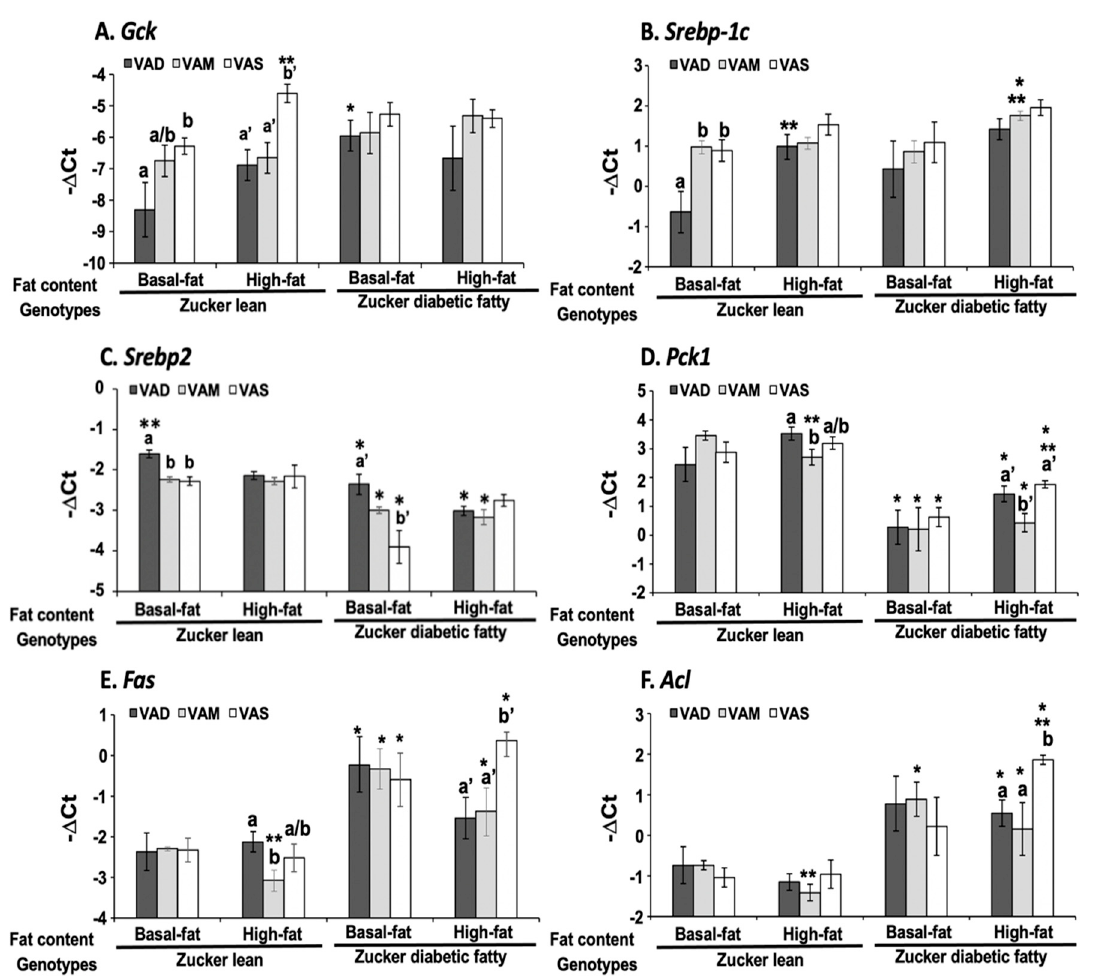
Figure 8. The mRNA levels of Gck (A) , Srebp ‐ 1c (B) , Srebp2 (C) , Pck1 (D) , Fas (E) , and Acl (F) in the liver of ZL and ZDF rats fed a VAD, VAM or VAS diet with BF or HF content. Total RNA was extracted and subjected to real ‐ time PCR analysis. The results are presented as means ± SEM of the ‐∆ CT, and n = 5–6 per group. For A, a < b, and a’ < b’; for B, a < b; for C, a > b, a’ > b’; for D, a > b, and a’ > b’; for E, a > b and a’ < b’; for F, a < b, for comparing the ZL or ZDF rats fed the diets with different VA status with the same fat content using one ‐ way ANOVA. All shown * for comparing ZL and ZDF groups fed the same diet; ** for comparing the ZL or ZDF rats fed the BF diet with those fed the HF diet with the same VA status; all p < 0.05. the HF diet with the same VA status; all p <